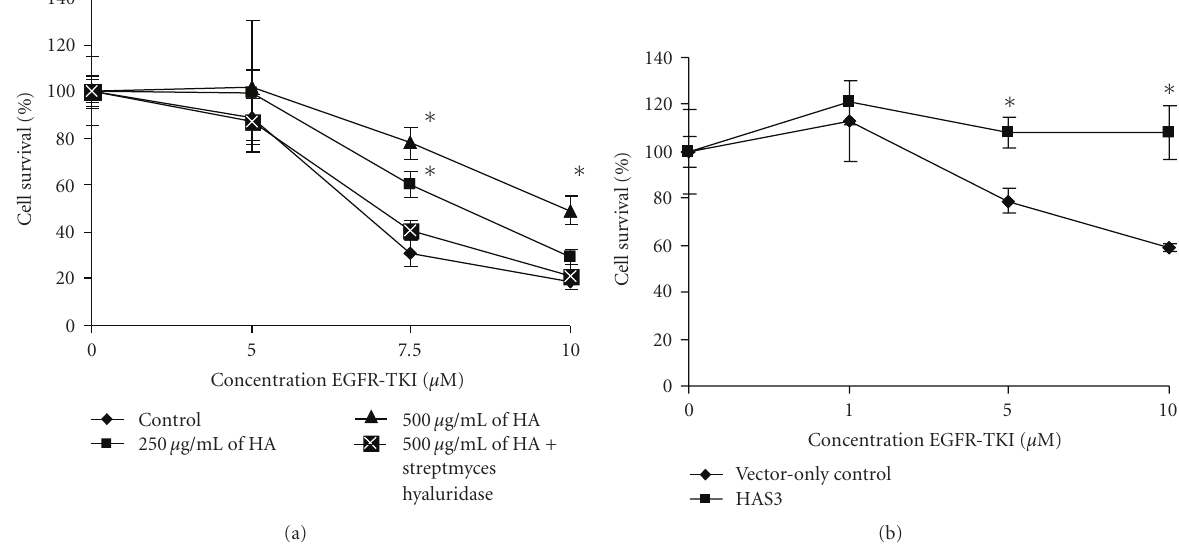
Figure 5: Exogenous HA and overexpression of HAS3 gene reduces sensitivity to EGFR-TKI in A549 and H358 cell lines. (a) A549 cells were seeded in a 96-well flat bottom plates and treated with either 250 μ g/mL or 500 μ g/mL of 132 kDa HA in the absence or presence of varying concentration of EGFR-TKI for 72 hours. To determine whether this reduced sensitivity is due to HA, 10 unit/mL of Streptomyces hyaluronidase were coincubated with 500 μ g/mL HA and treated with varying concentration of EGFR-TKI for 72 hours. The in vitro EGFR- TKI sensitivity of A549 cells was evaluated by cell proliferation assay. (b) HAS3 and vector-only control were cultured for 48 hours before treatment in the absence or presence of varying concentration of EGFR-TKI for 72 hours before assaying for cell growth. The experiments were repeated three times. A representative is shown for (a) and (b). (Values are mean ± SD, n = 6, ∗ P < .